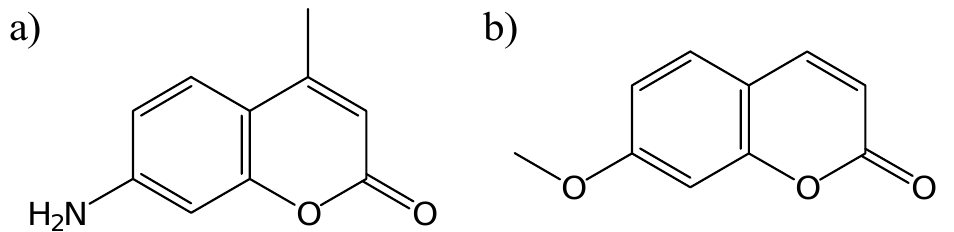
Figure 3 . The chemical structures of a) coumarin derivative C120; b) 7-methoxycoumarin